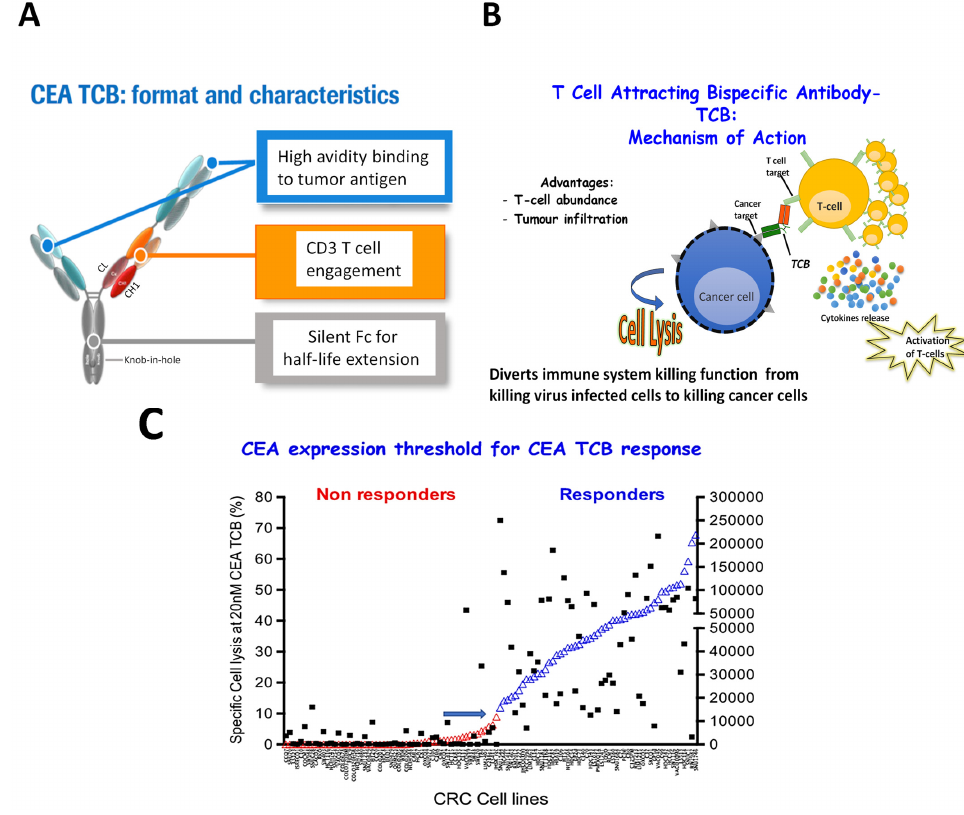
Figure 3. ( A ) T Cell Attracting Bispecific Antibody-TCB: Mechanism of Action. ( A ) The bivalent CrossMab knob-in-hole format of the CEA TCB antibody is shown [17]. ( B ) CEA TCB mechanism of action . ( C ) CEA T cell bi-specific (TCB) response correlates with CEA expression. Two categories of response to TCB-based lysis: Cell lines with above 10,000 surface CEA molecules (blue symbol) nearly all more than 10% lysis. Cell lines with below 10,000 surface CEA molecules (red symbol) are nearly all less than 10% lysis. Right-hand X-axis: Blue triangle shows the cell line level of expression responders. Red triangle shows the cell line level of expression non-responders. Left-hand axis; Black square shows the percent of cell lysis of cell line corresponding to the expression level symbol.